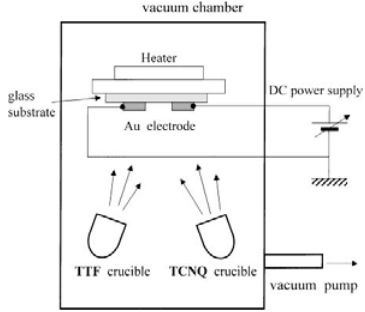
Figure 26. Schematic diagram of the applied electric field deposition method. [Reproduced with permission from [21] Jpn. J. Appl. Phys. 2003 , 42 , 2488–2491. ©2003, Japanese Society of Applied Physics].